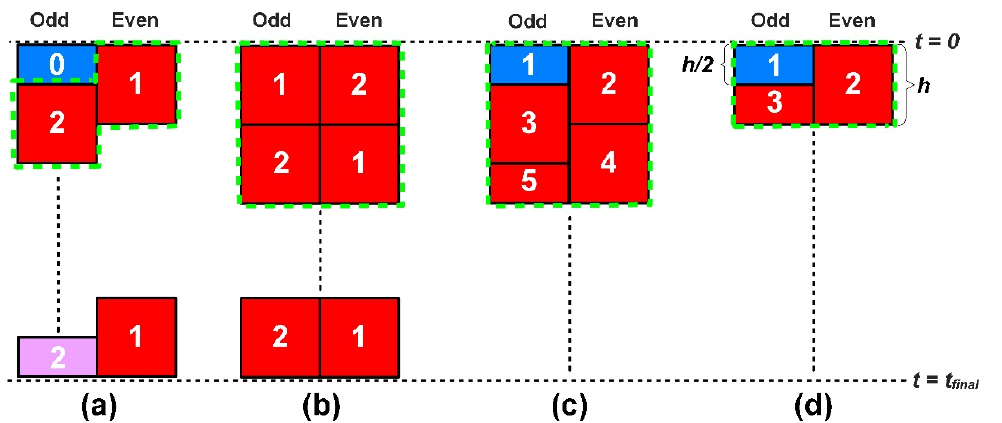
Figure 3. Space-time structure of the hopscotch-type methods. ( a ) Leapfrog-hopscotch (LH), ( b ) original odd-even hopscotch (OOEH), ( c ) shifted-hopscotch (SH), ( d ) asymmetric hopscotch (ASH).